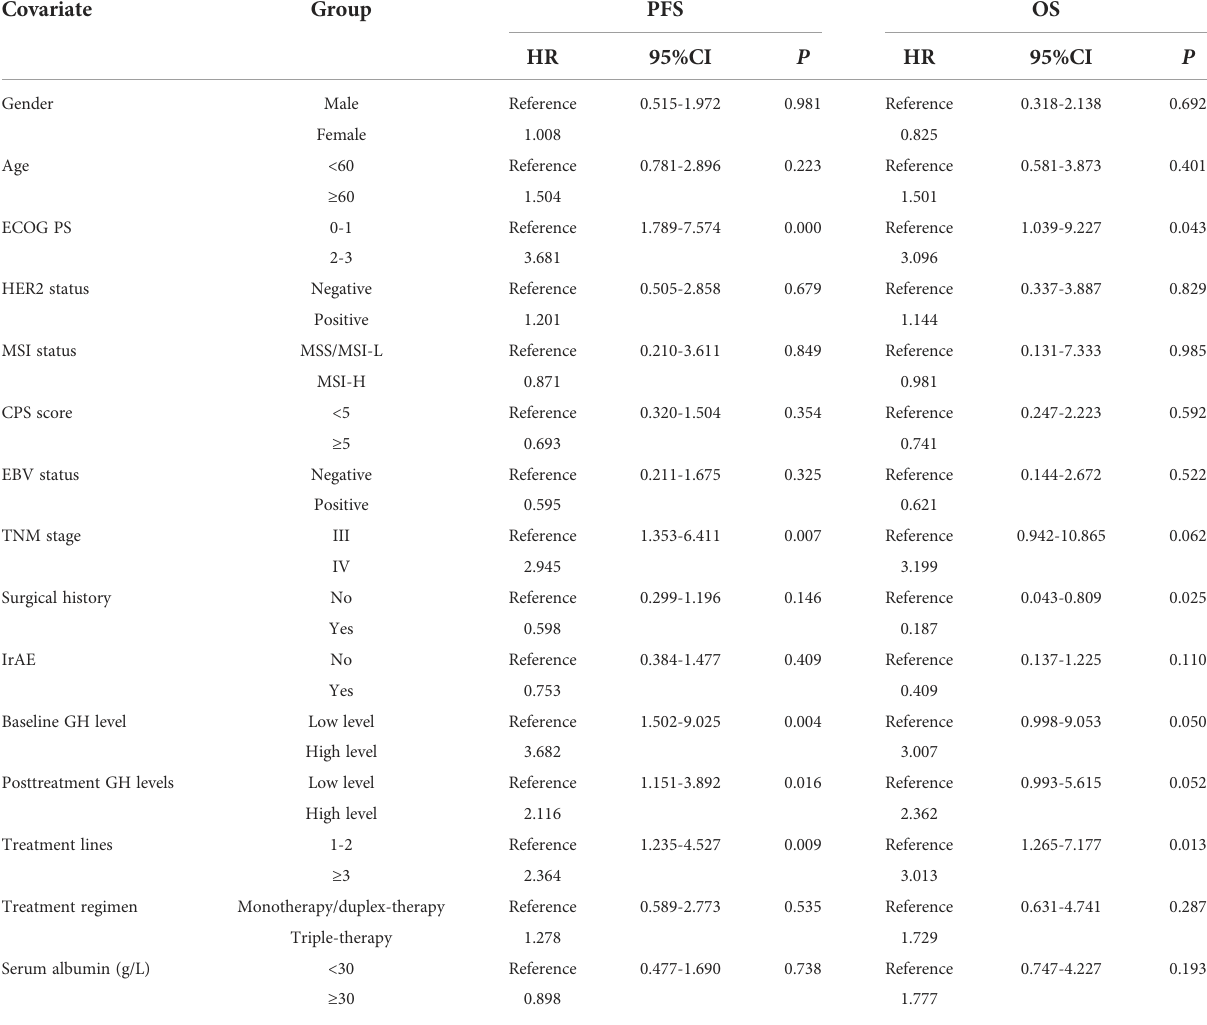
TABLE 3 Univariate analyses of progression-free survival and overall survival.